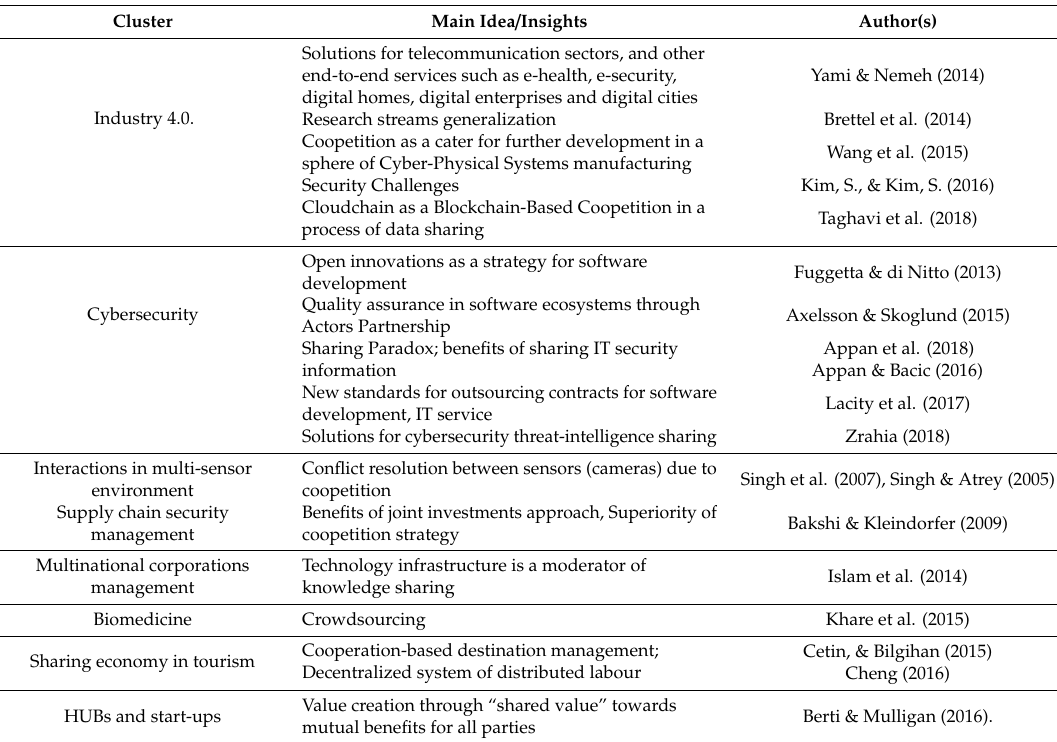
Table 3. Cluster analysis of the content for the chosen papers in a field of research: new challenges in safety &